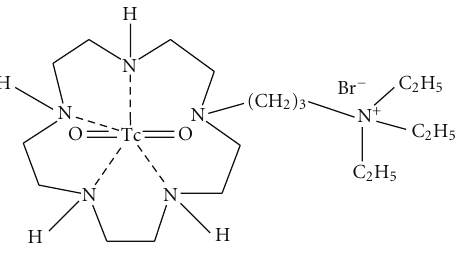
Figure 1: Chemical structure of 99m Tc-N-[triethylammonium]-3- propyl-[15]ane-N5 ( 99m Tc-NTP 15-5).